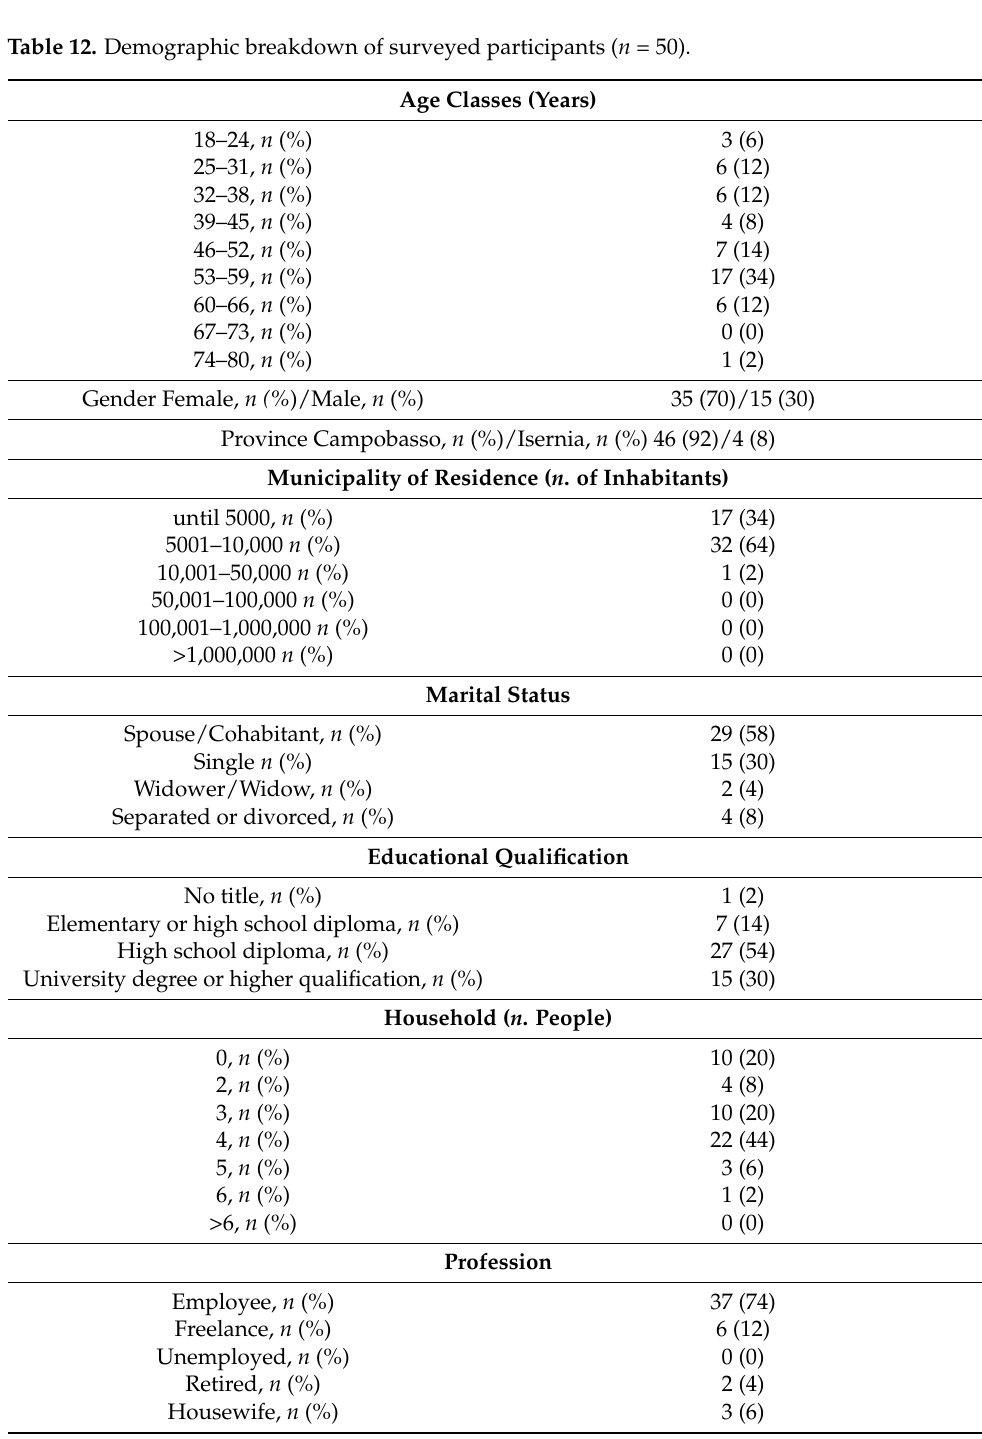
Table 12. Demographic breakdown of surveyed participants ( n =